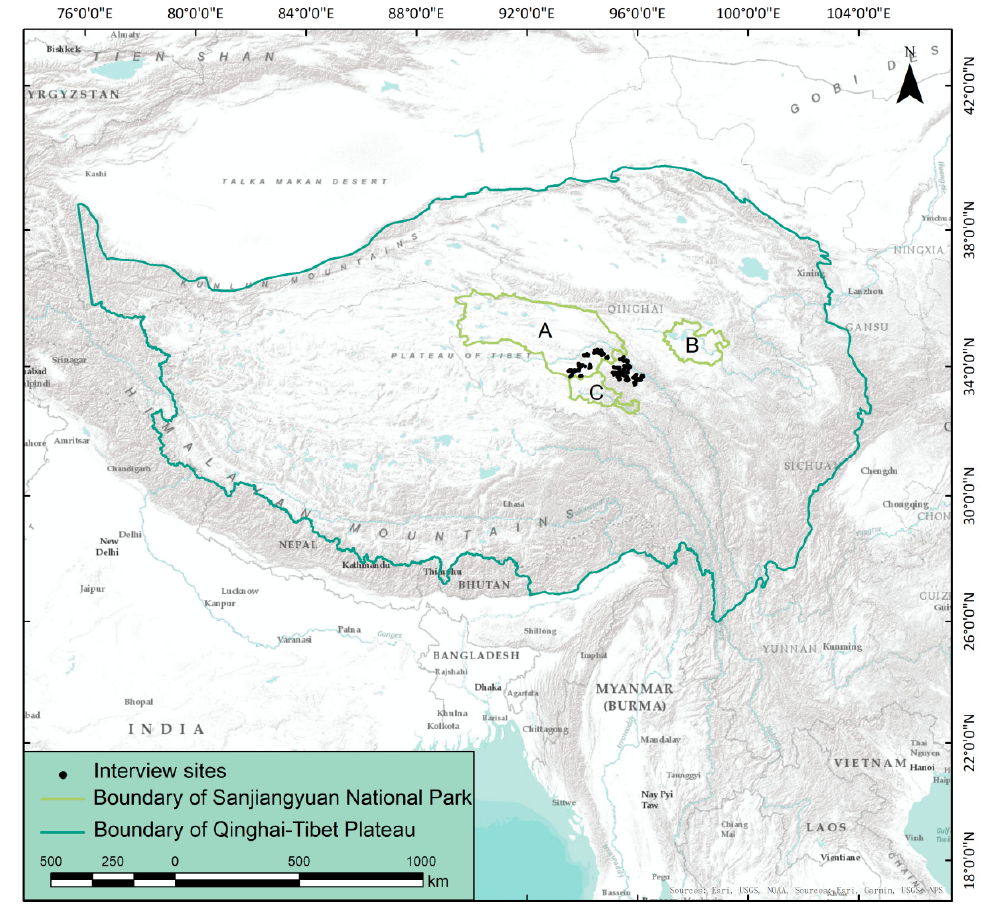
Figure 2. Interview locations in Zhiduo County, Qinghai-Tibetan Plateau, China. A refers to the Yangtze River Zone of Sanjiangyuan National Park (SNP); B refers to the Yellow River Zone of SNP; C refers to the Lancang River Zone of SNP.